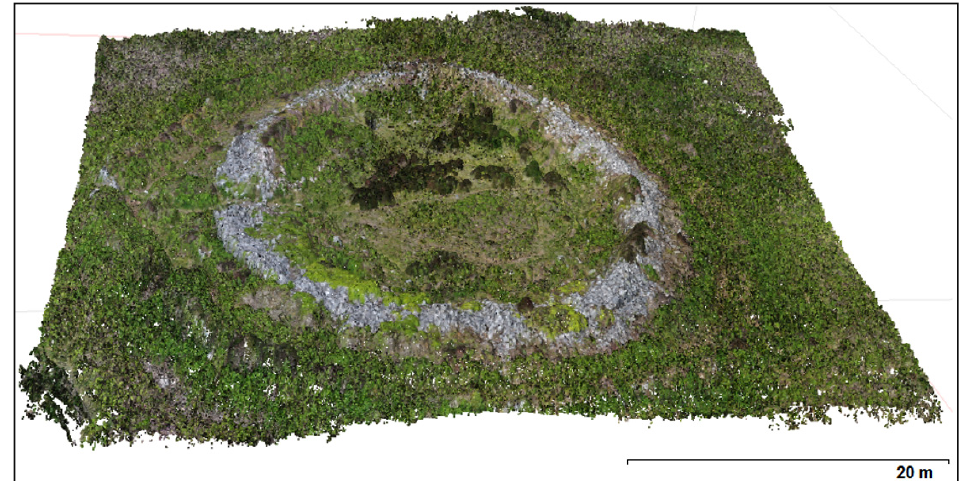
Figure 3. Dense point clouds representing Chun Castle site in RGB (Red, Green and Blue) colors obtained from UAV-derived Structure from Motion (SfM) photogrammetry.